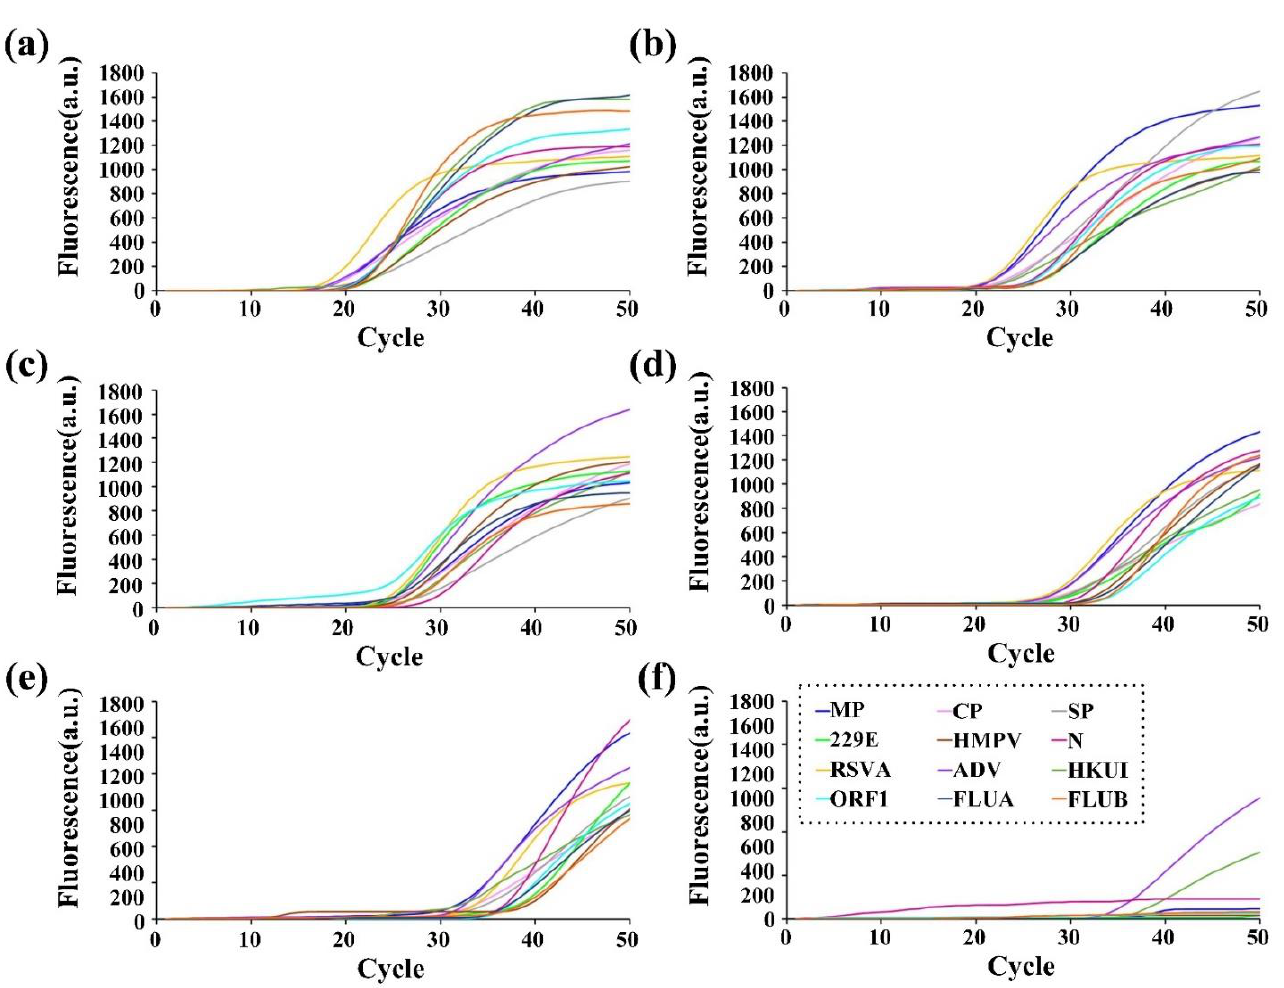
Figure 4. The sensitivity of the microfluidic RT-qPCR assay on-chip. Amplification curves of MP, CP, SP, RSVA, ADV, HKU1, 229E, HMPV, N, ORF1, FLUA and FLUB are shown in detection of ( a )